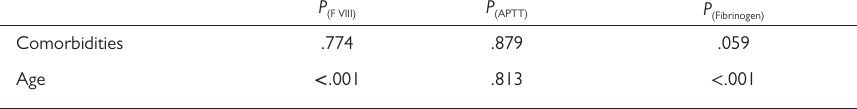
Table 3. The Influence of Age and Comorbidities on Factor VIII, APTT, and Fibrinogen Levels